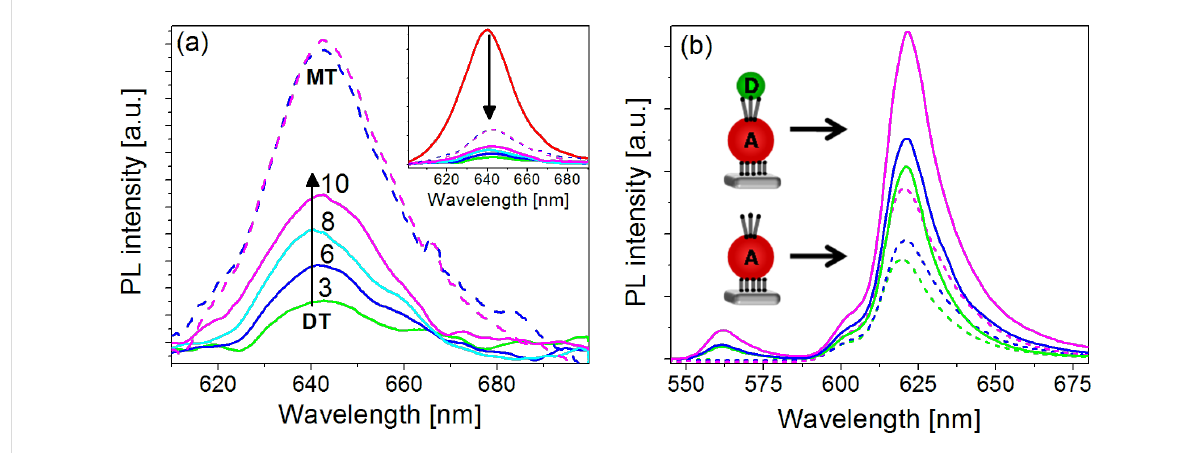
Figure 2: (a) PL spectra of acceptor NP monolayers at 300 K when covered with MT (dashed) or DT (solid) molecules of various lengths (C 3 -green, C 6 -blue, C 8 -cyan, C 10 -magenta). The inset shows the quenching of the untreated monolayer (red) upon the adsorption of the thiols. (b) PL spectra of acceptor NPs only (dotted) at 15 K covered with DT molecules of various lengths (C 3 DT-green, C 6 DT-blue, and C 10 DT-magenta) and spectra of donor–acceptor NP bilayers (solid) with the same linker